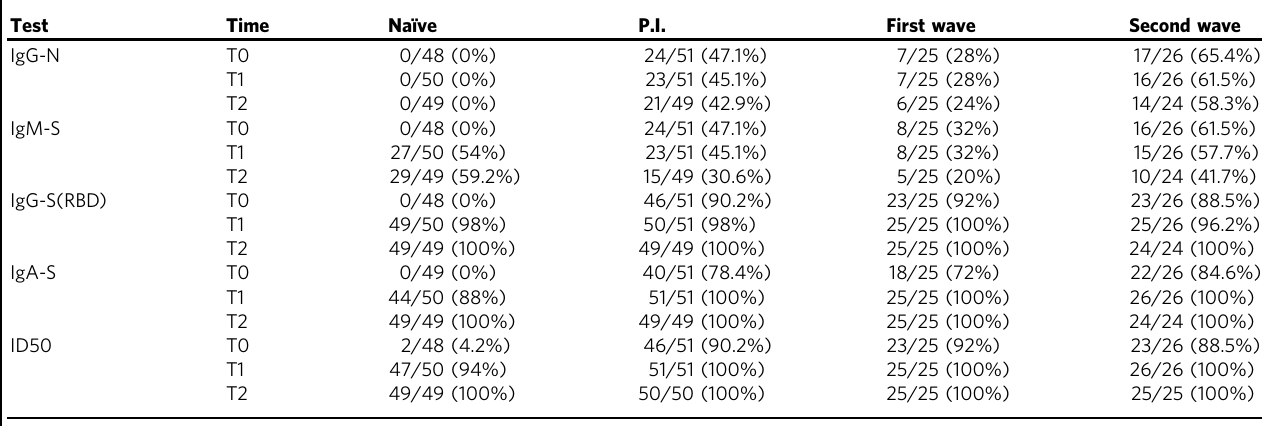
Table 2 Antibody and neutralization assays (positives/total and percent).